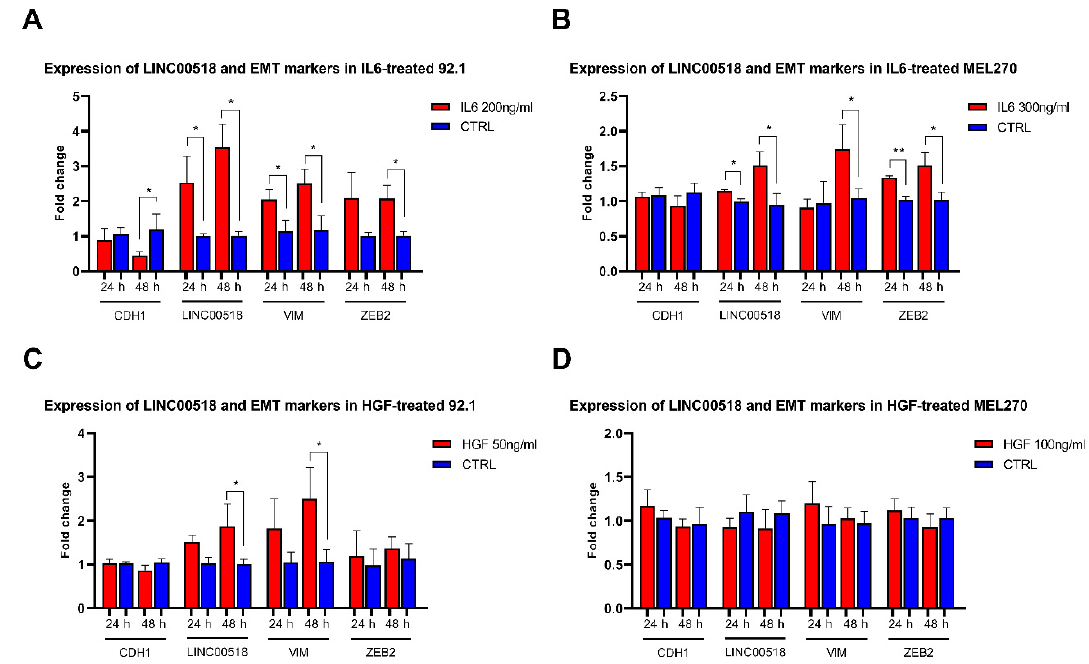
Figure 3. Expression of epithelial to mesenchymal transition (EMT) markers and LINC00518 in uveal melanoma (UM) cells treated with interleukin 6 (IL6) and hepatocyte growth factor (HGF). ( A ) 92.1 cells treated with IL6. ( B ) MEL270 cells treated with IL6. ( C ) 92.1 cells treated with HGF. ( D ) MEL270 cells treated with HGF. Each experiment was performed in three in vitro replicates. *: p -value < 0.05; **: p -value < 0.005.